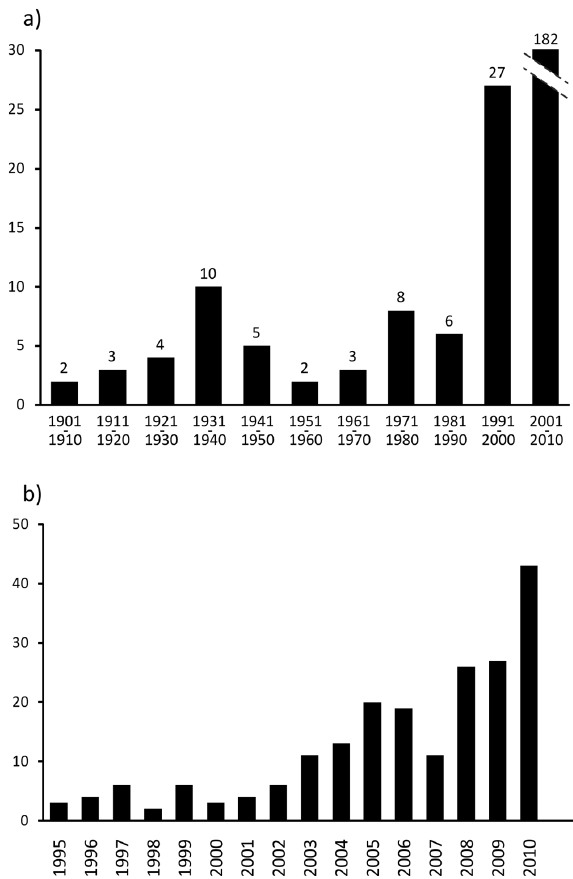
Fig. 3. (a) Rockfall count on the decadal scale from 1900–2010; (b) annual rockfall count from 1995–2010.